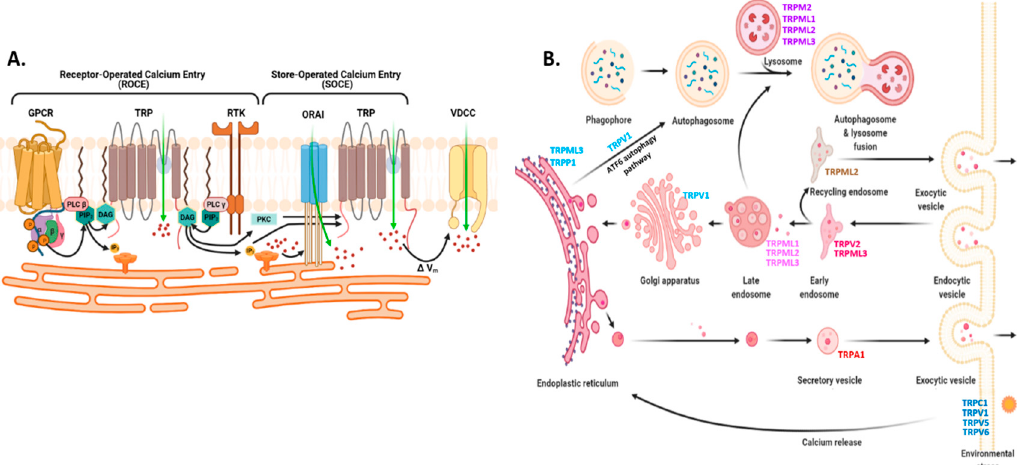
Figure 6. Many roles of TRP channels in intracellular Ca 2+ homeostasis. ( A ) TRP channels drive Ca 2+ influx either through Receptor-Operated Ca 2+ Entry or Store-Operated Ca 2+ Entry. ROCE requires activated GPCRs or Receptor-tyrosine kinases to initiate phospholipase C beta (PLC β ) or PLC γ mediated hydrolysis of phosphatidylinositol 4,5-bisphosphate (PIP 2 ) into diacylglycerol (DAG) and inositol 1,4,5-triphosphate (yellow circles) after which DAG binds to a TRP channel to stimulate the inflow of Ca 2+ ions. IP 3 generated via PIP 2 hydrolysis triggers a reduction in Ca 2+ ion levels in the endoplasmic reticulum by simultaneously promoting the release of the cations through IP 3 receptors (IP 3 Rs) [54,63,69,71,72,76–78]. This results in the formation of SOC complex (ORAI-STIM or ORAI-TRP-STIM) for transporting Ca 2+ ions from extracellular space into the cytosol. Some TRP isoforms can also be activated by direct binding of protein kinase C that triggers Ca 2+ influx (or sodium influx) followed by membrane depolarization leading to more Ca 2+ influx via the opening of voltage- dependent Ca 2+ channels [54]. Other TRP isoforms (especially expressed in muscle cells) can directly induce Ca 2+ release from IP 3 Rs on the ER membrane (Ca 2+ -induced Ca 2+ release or CICR; not shown); ( B ) TRP channels are expressed on intra- cellular membranes as well where they play an active role in the regulation of Ca 2+ ion concentration during processes such as autophagy, endocytosis, and exocytosis (58,61,75). DAG, D iacylglycerol ; GPCRs , G-protein coupled re c eptors; IP 3 , inositol 1,4,5-triphosphate ; ORAI (Ca 2+ release activated Ca 2+ modulator; RTKs, Receptor-tyrosine kinases ; ROCE, Receptor- Operated Ca 2+ Entry ; SOC, s t ore-oper a ted Ca 2+ ; SOC E , Store-Operated Ca 2+ Entry ; STIM, stromal interaction molecule; PIP 2 , phosphatidylinositol 4,5-bisphosphate ; PKC, protein kinase C ; TRP , tran s i e nt receptor pot e ntial; VDCCs , voltage-dependent Ca 2+ channels .